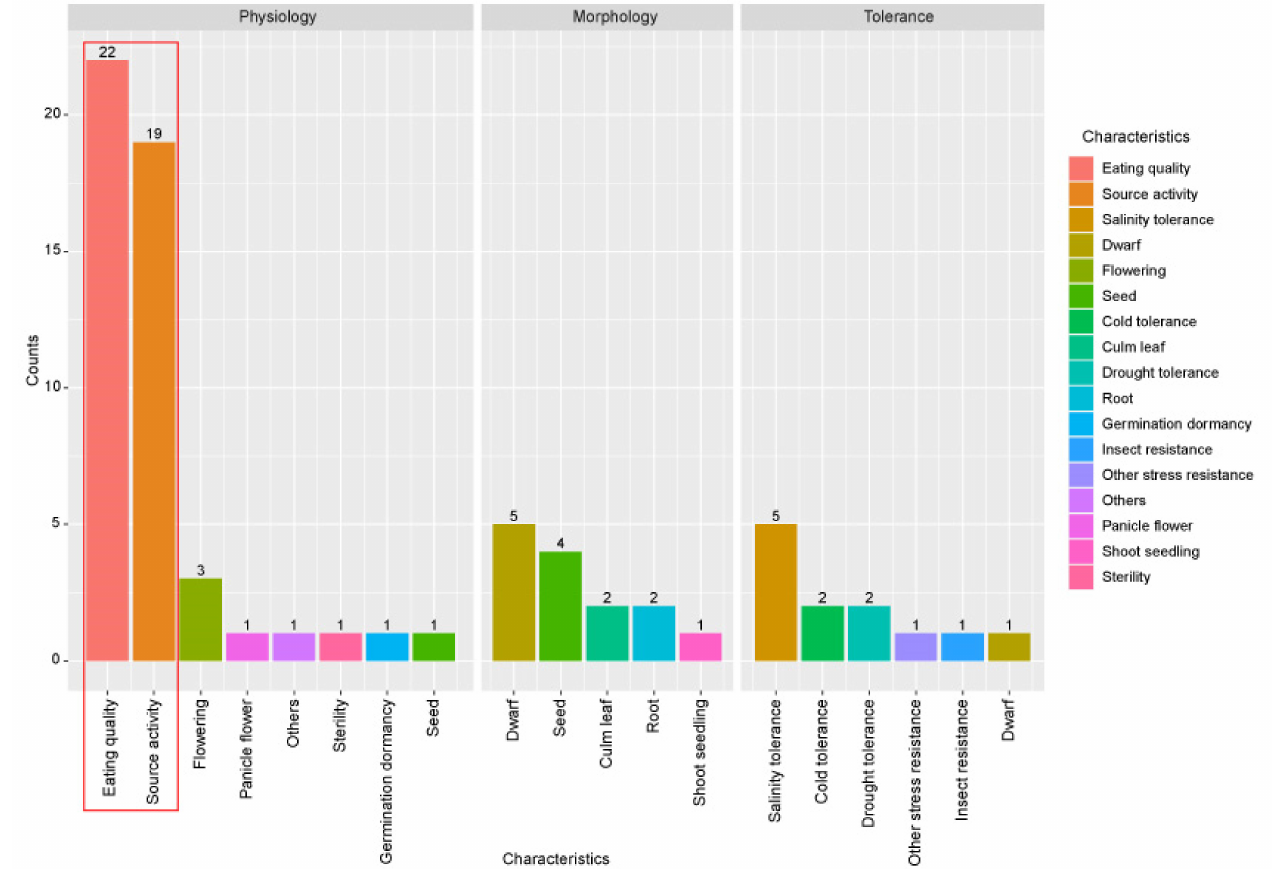
Figure 2. Distribution of functionally characterized genes from 866 carbohydrate metabolism-related genes according to phenotype. A literature search was performed to analyze the functional significance of the 866 carbohydrate metabolism- related genes. Functionally characterized gene information was retrieved from the OGRO database. To visualize the results of the 76 functionally characterized genes indicated in Table 1, three categories of major characteristic information from the OGRO database were used: physiology, morphology, and tolerance/resistance. The number of characterized genes was counted according to the minor characteristics within three major categories: physiology, morphology, and tolerance. The red box indicates the most enriched minor characteristics of the functions associated with the 76 functionally characterized